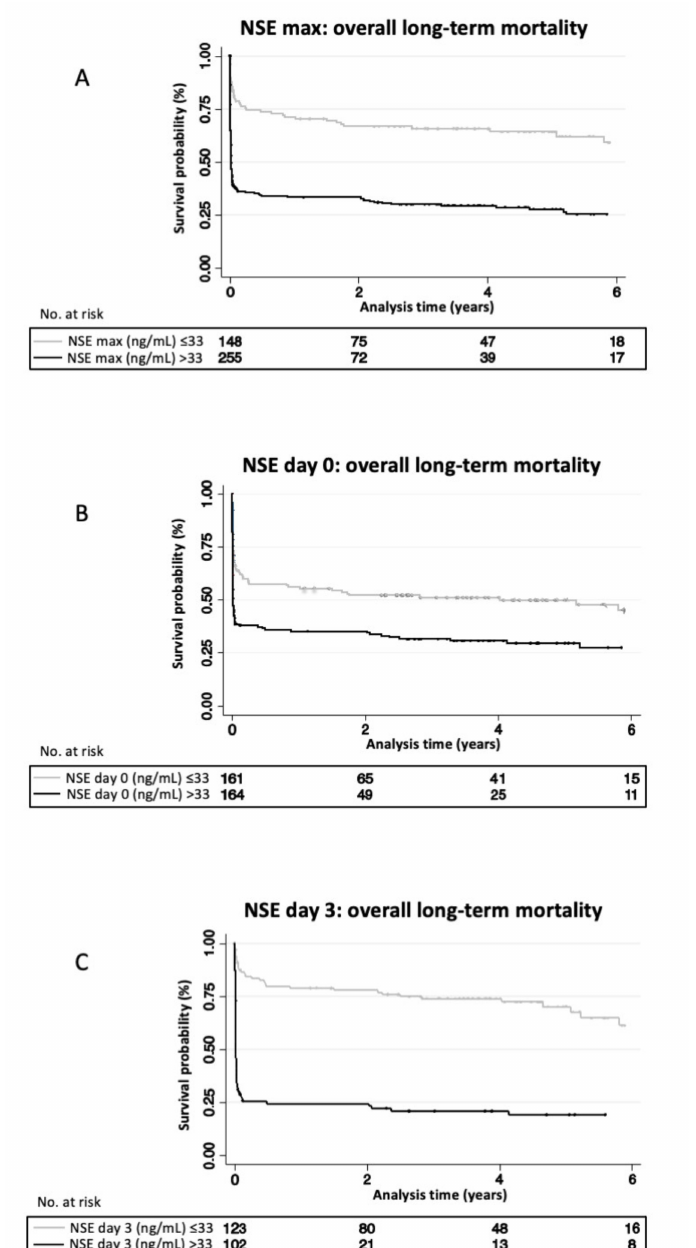
Figure 1. NSE levels associated with overall long-term mortality: Kaplan-Meier curves stratified by serum NSE-concentrations above and below 33ng/mL using maximal NSE measured ( A ), measured on day 0 ( B ) and measured on day 3 ( C ). Log-Rank Test of NSE max p < 0.001; Log-Rank Test of NSE day 0 p < 0.001; Log-Rank Test of NSE day 3 p < 0.001. NSE, neuron specific